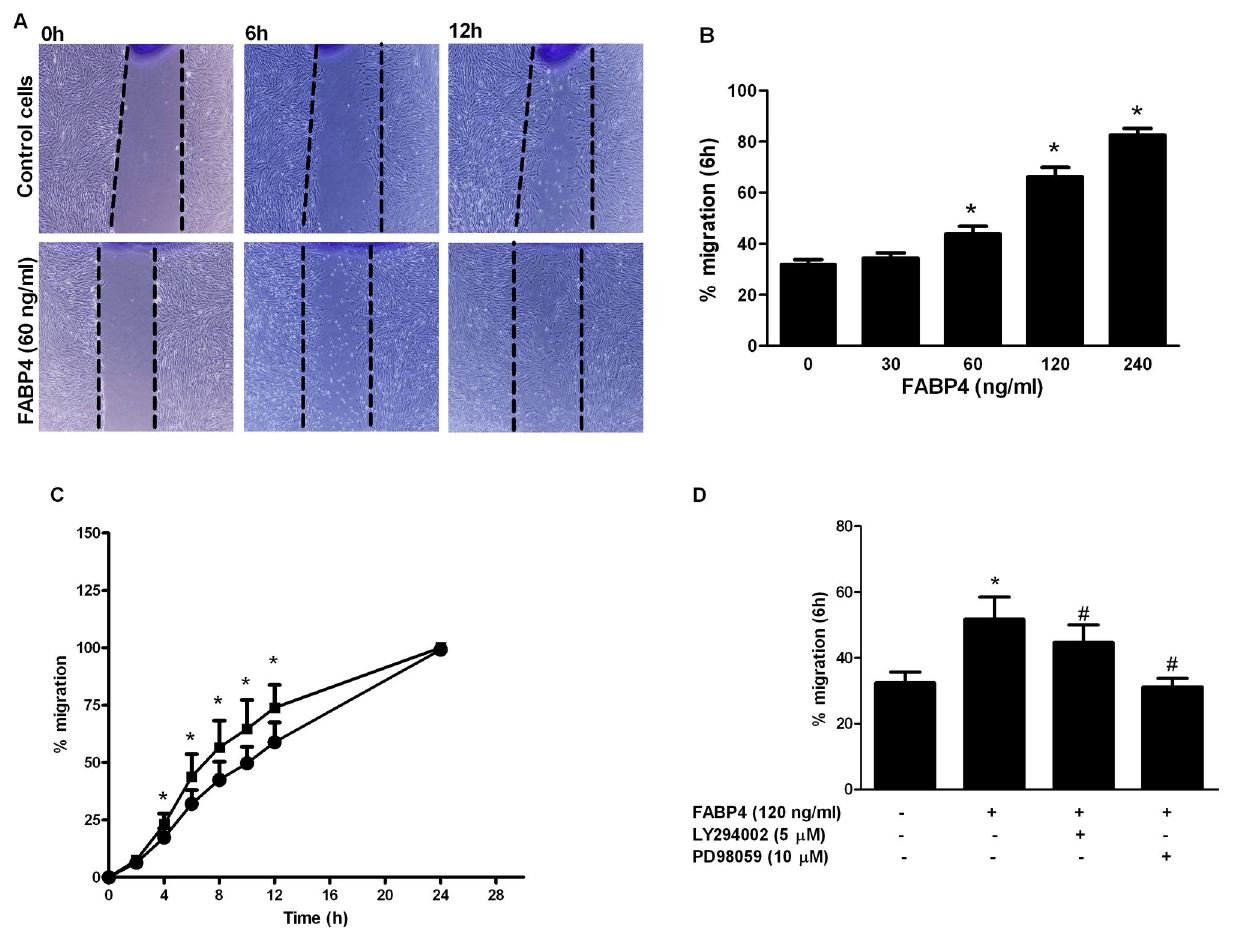
Figure 2. Effect of FABP4 on HCASMC migration. (A) An in vitro wound-healing assay indicates that FABP4 at 60 ng/ml induced HCASMC migration. Confluent cells were scratch wounded and allowed to migrate for 12 h. Representative images of the cells after 0 h, 6 h and 12 h of migration are shown. Photomicrographs of the cell images were obtained at 100x magnification in a phase-contrast microscope. (B) The effects of FABP4 (30-240 ng/ml) on HCASMC migration after 6 h of treatment. The results are shown as the percentage of increase in relation to the cells treated with medium alone (control). (C) A time-course (0-24 h) of the effect of 60 ng/ml FABP4 on HCASMC migration. (D) The effect of LY294002 (5 µM) and PD98059 (10 µM) on FABP4-induced HCASMCs at 6 h. *p<0.05 vs unstimulated cells; #p<0.05 vs FABP4-stimulated cells. The results are shown as a percentage of the migration rate. The results are expressed as the mean ± SEM of three experiments run in sextuplicate. *p<0.05 vs. unstimulated cells